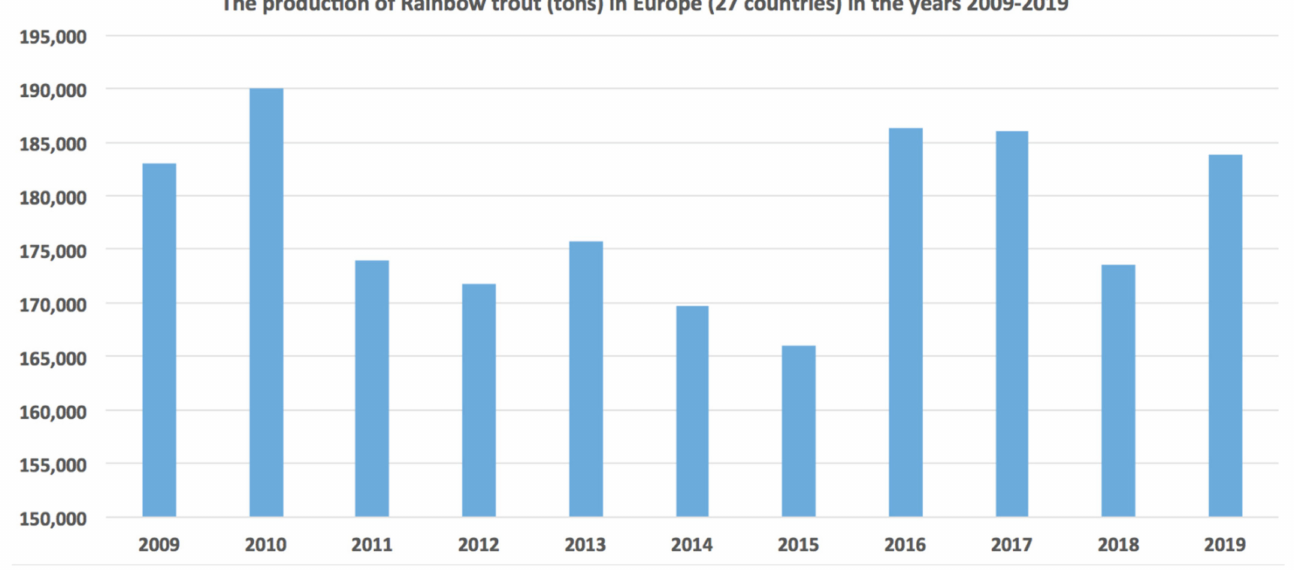
Figure 3. The production of rainbow trout (tons) in Europe (27 countries) in the years